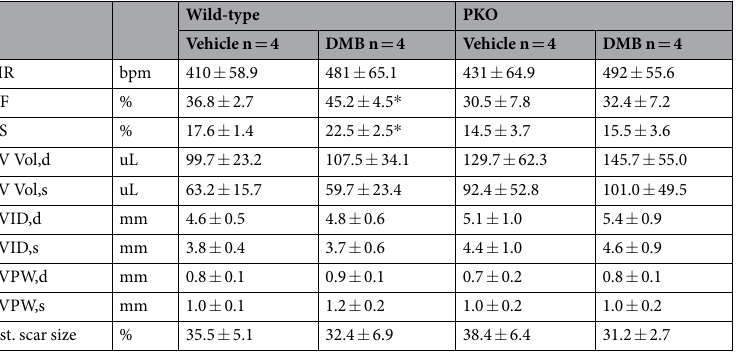
Table 2. DMB administered after permanent coronary artery ligation fails to mitigate MI-induced adverse LV remodeling and improve cardiac function in PKO mice. Echocardiograms were analyzed on day 14 post- permanent coronary artery ligation. Data is presented as mean ± standard deviation. HR, Heart rate; EF, Ejection Fraction; FS, Fractional Shortening; DMB, 2-Quinoxalinamine, 6,7-dichloro-N-(1,1-dimethylethyl)- 3-(methylsulfonyl)-, 6,7-dichloro-2-methylsulfonyl-3-N-tert-butylaminoquinoxaline; LV Vol,d, Left Ventricle End-Diastolic Volume; LV Vol,s, LV End- Systolic Volume; LVID,d, LV Internal Diameter, Diastole; LVID,s, LV Internal Diameter, systole; LVPW,d, LV Posterior Wall thickness, diastole; LVPW,s, LV Posterior Wall thickness, systole. Naïve EF % 60.4 ± 6.7, FS % 29.3 ± 6.3 (n = 19); PKO baseline - EF % 56.2 ± 4.5, FS % 27.8 ± 2.3 (n = 9). * p < 0.05 vs